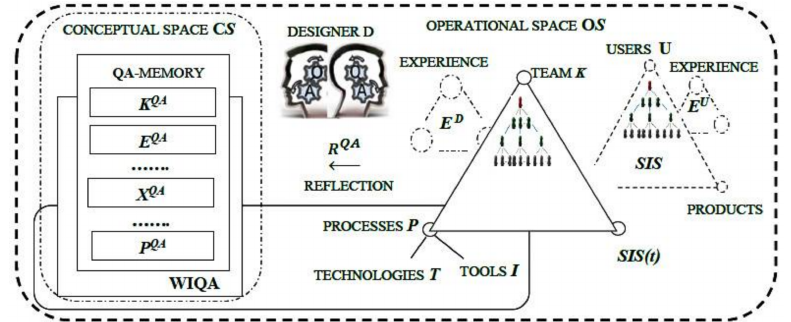
Figure 2. The common view on